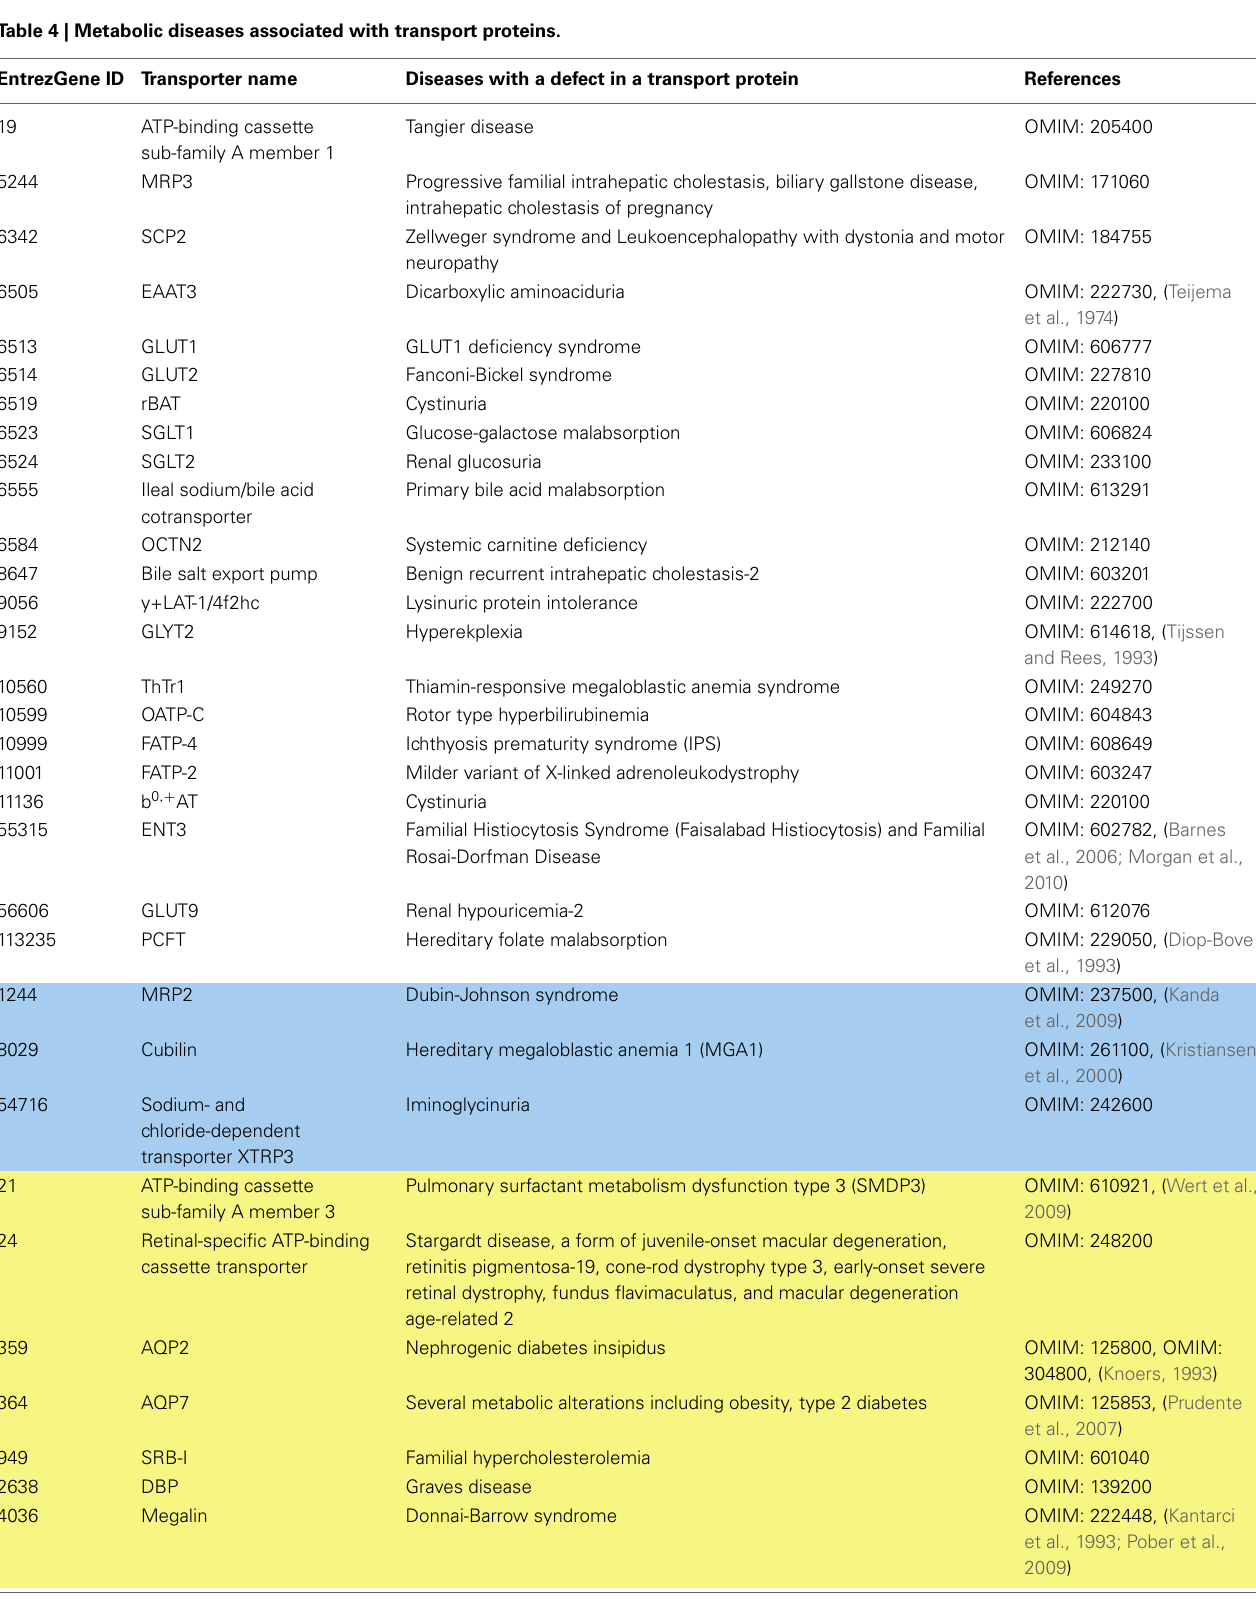
Table 4 | Metabolic diseases associated with transport proteins. EntrezGene ID Transporter